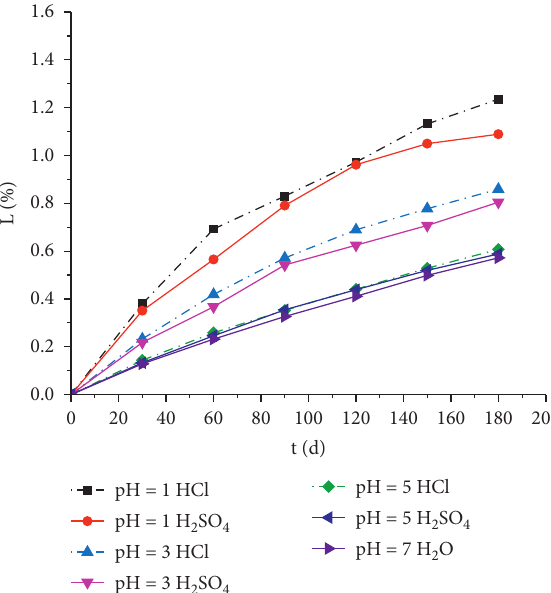
Figure 5: Mass loss rate curves of sandstone samples in different pH